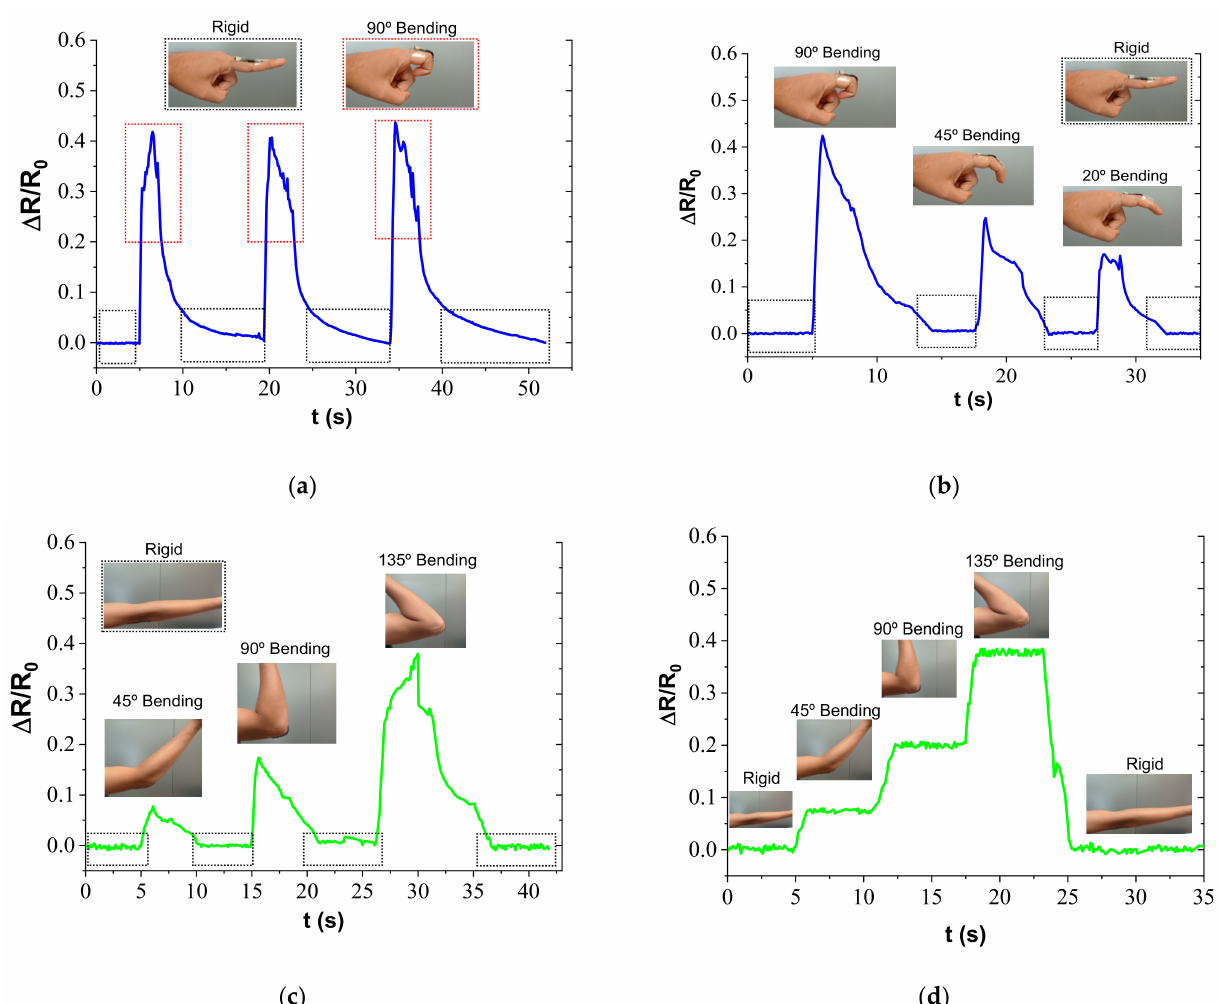
Figure 8. Electrical response to human motion monitoring when ( a , b ) finger and ( c , d ) elbow bending–